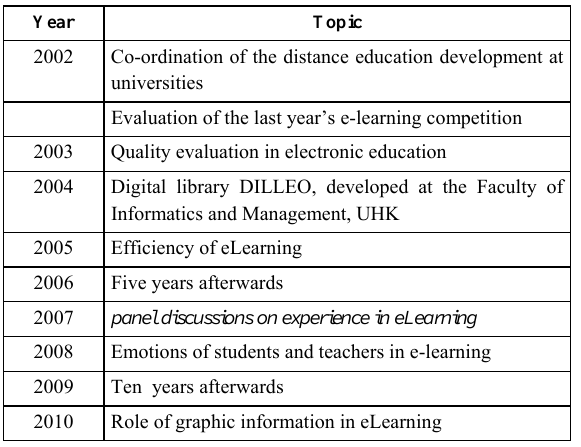
TABLE II. K EY C ONFERENCE T OPICS